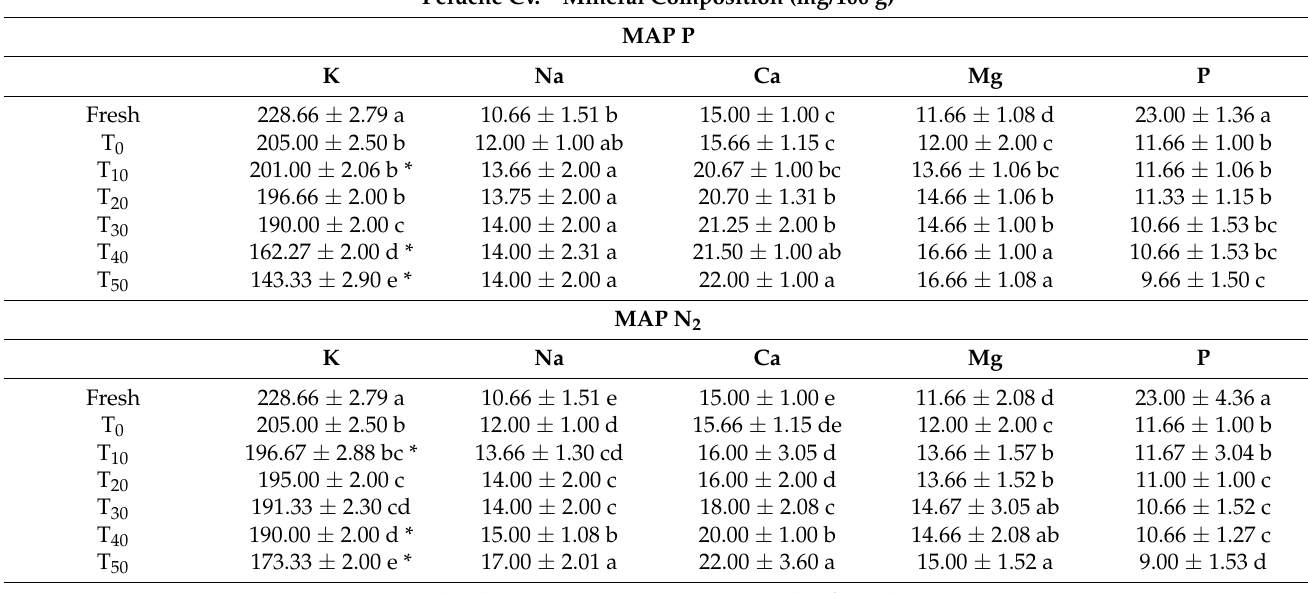
Table 4. Content of K, Na, Ca, Mg, and P per 100 g of fresh product, dehydrated (T 0 ) and after 10, 20, 30, 40, and 50 days of storage with MAP P and MAP N 2 . The table shows means ± SD ( n = 3); lower case letters show statistically significant differences ( p ≤ 0.05) and the * indicates statistically significant differences between minerals in fruit packed with different